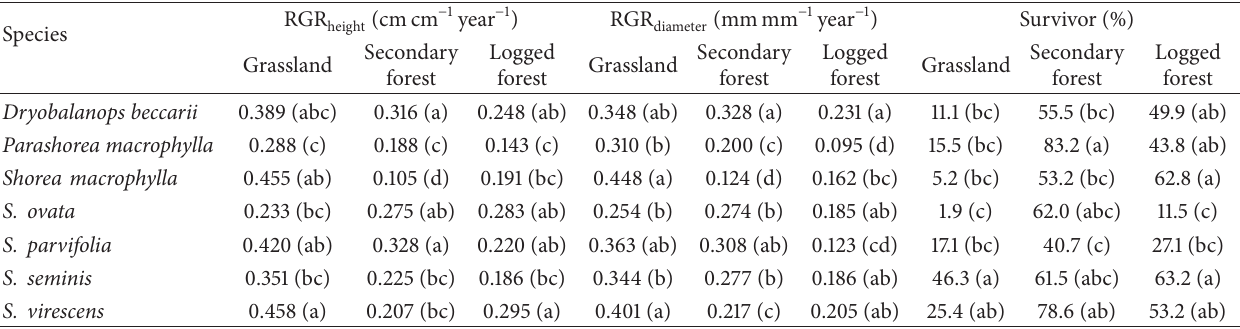
Table 2: Relative growth rate in height (RGR over 62 months of seven dipterocarp forest species.